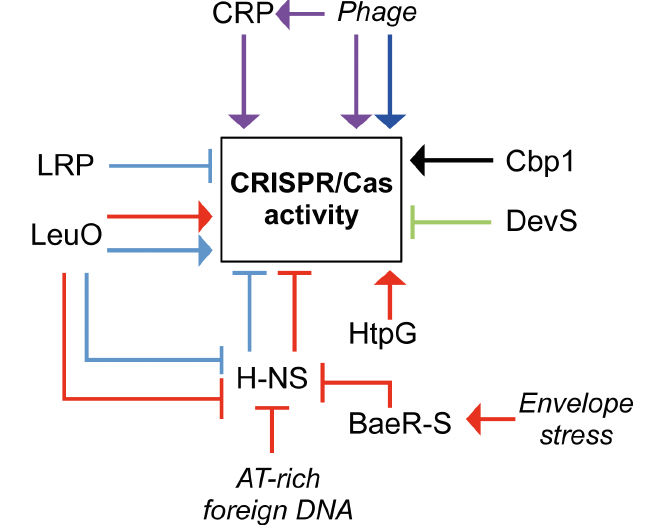
Figure 4. Regulation of CRISPR/Cas activity. Network model summarizing the regulation of CRISPR/Cas activity. Triangular and flat arrowheads indicate positive and negative effects on CRISPR/Cas activity, respectively for E. coli (red), Salmonella (cyan), M. xanthus (green), Sulfolobus (black), T. thermophilus (purple) and S. thermophilus (blue). For details see